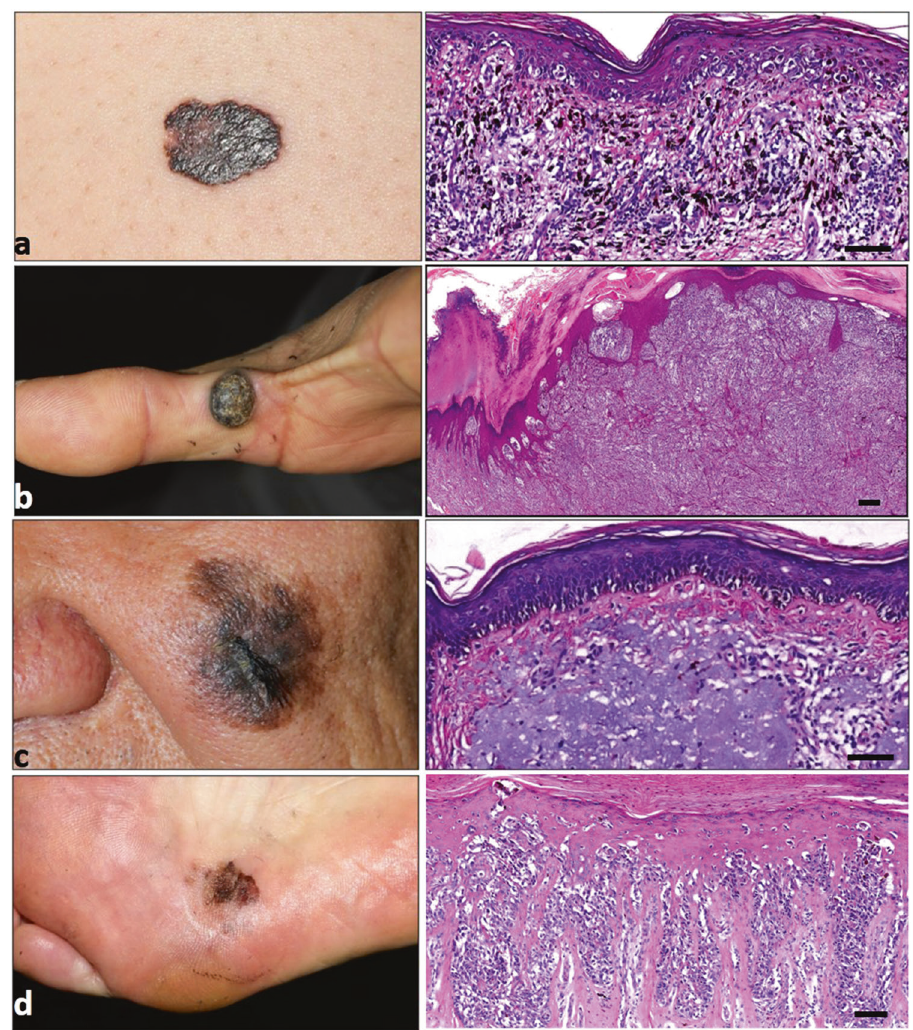
melanoma ( c ), and acral lentiginous melanoma ( d ). The corresponding histopathological image of the same patient is displayed on the right. Scale bar = 100 μ